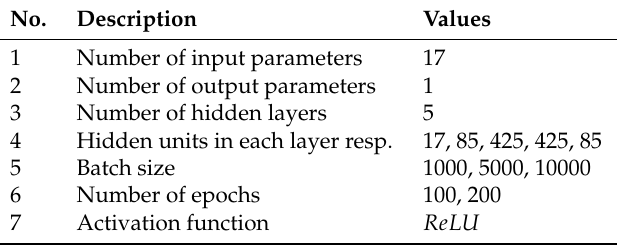
Figure 15. Traffic occupancy: Actual and predicted values (average of all VDS) (48 h). Table 5. Traffic occupancy: Deep model